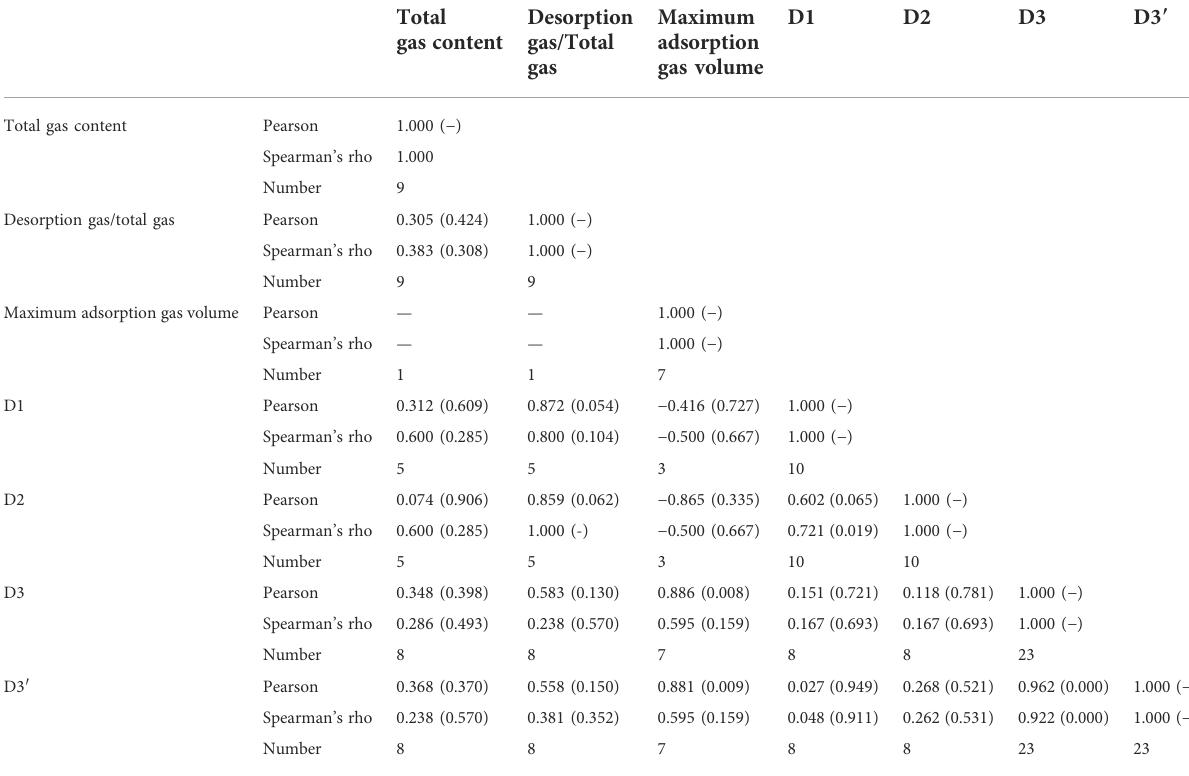
TABLE 2 The correlation analysis results of the gas content and the fractal dimensions.